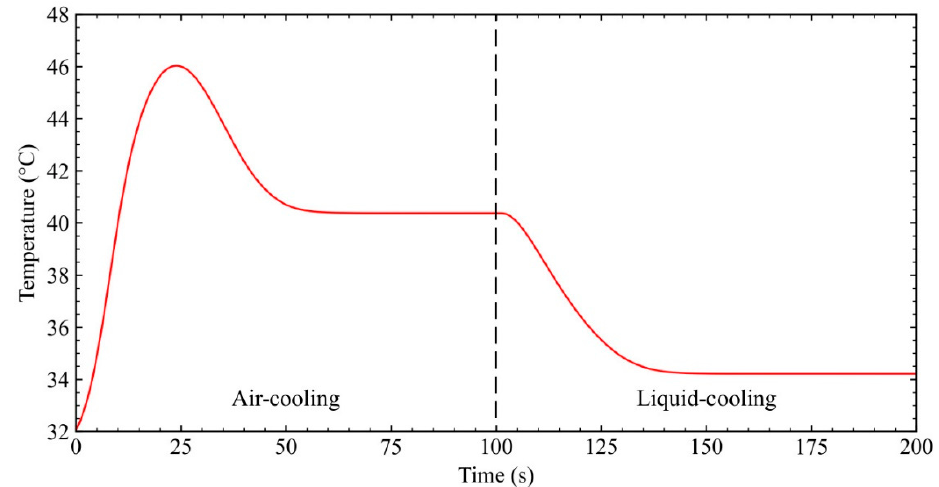
Figure 19. Time variation of the exhaust temperature of the liquid-cooled server.